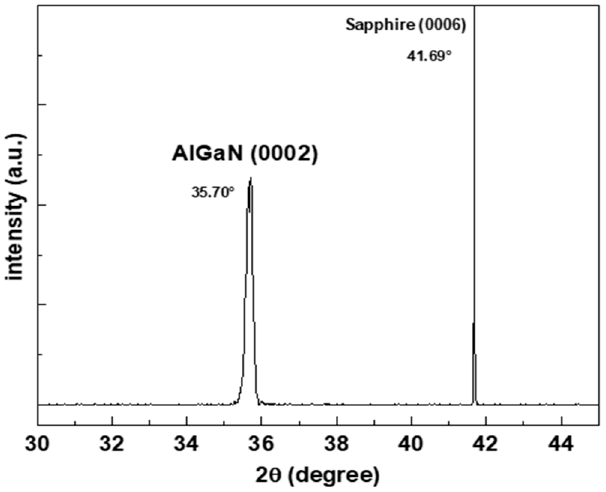
Figure 2. On sapphire substrate, the Al 0.6 Ga 0.4 N buffer layer was characterized by XRD. Table 1. Hall test results of the Al 0.6 Ga 0.4 N buffer layer.